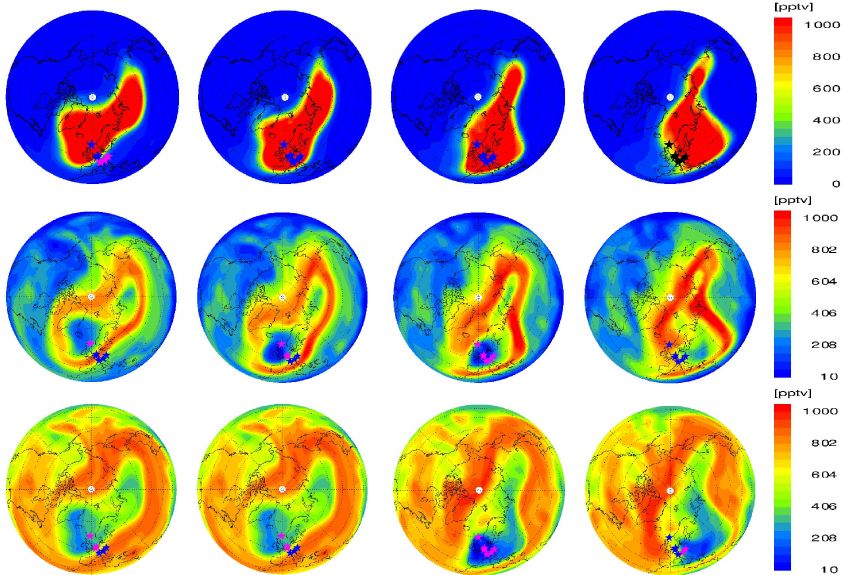
Fig. 13. Active Chlorine (ClO x , top row), chlorine nitrate (ClONO 2 , middle row) and hydrochloric acid (HCl, bottom row) as simulated by E5/M1 for 17 to 20 January 2006, 12:00UT, for 2 = 500K; the six sounding stations are marked by stars (different colours for better